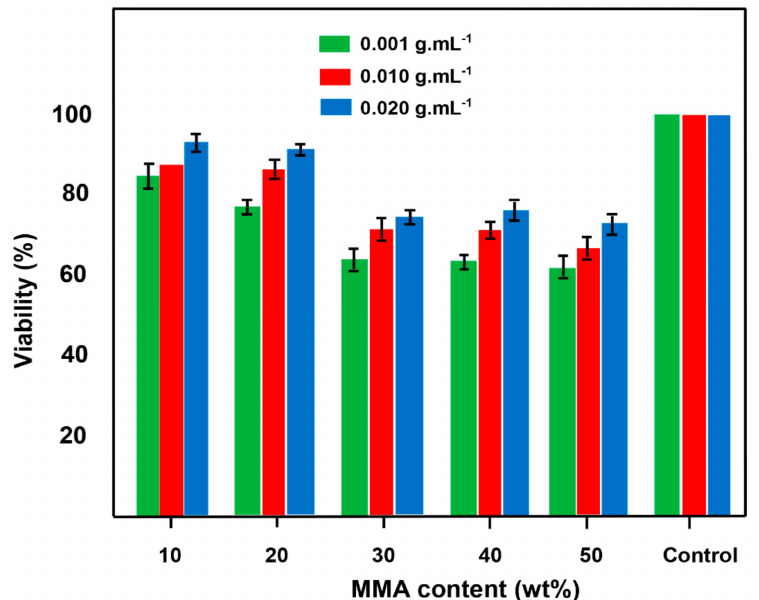
Figure 11. The diagram of the in vitro cytotoxicology text of PHEMMAC film specimens on L929 cells after 24 h of